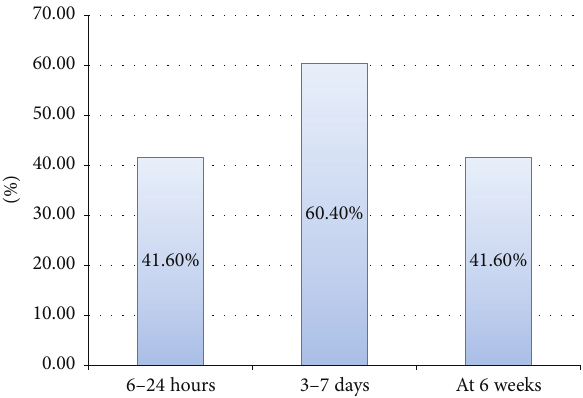
Figure 1: Postnatal care services on recommended time of visit among postnatal care service utilizers at Debre Markos town, Northwest Ethiopia, December, 2014 ( 𝑛 = 197